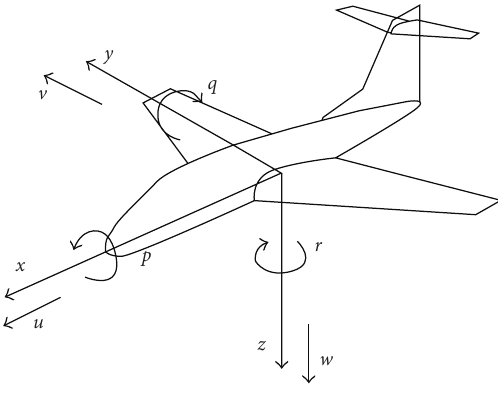
Figure 9: Adopted reference coordinate